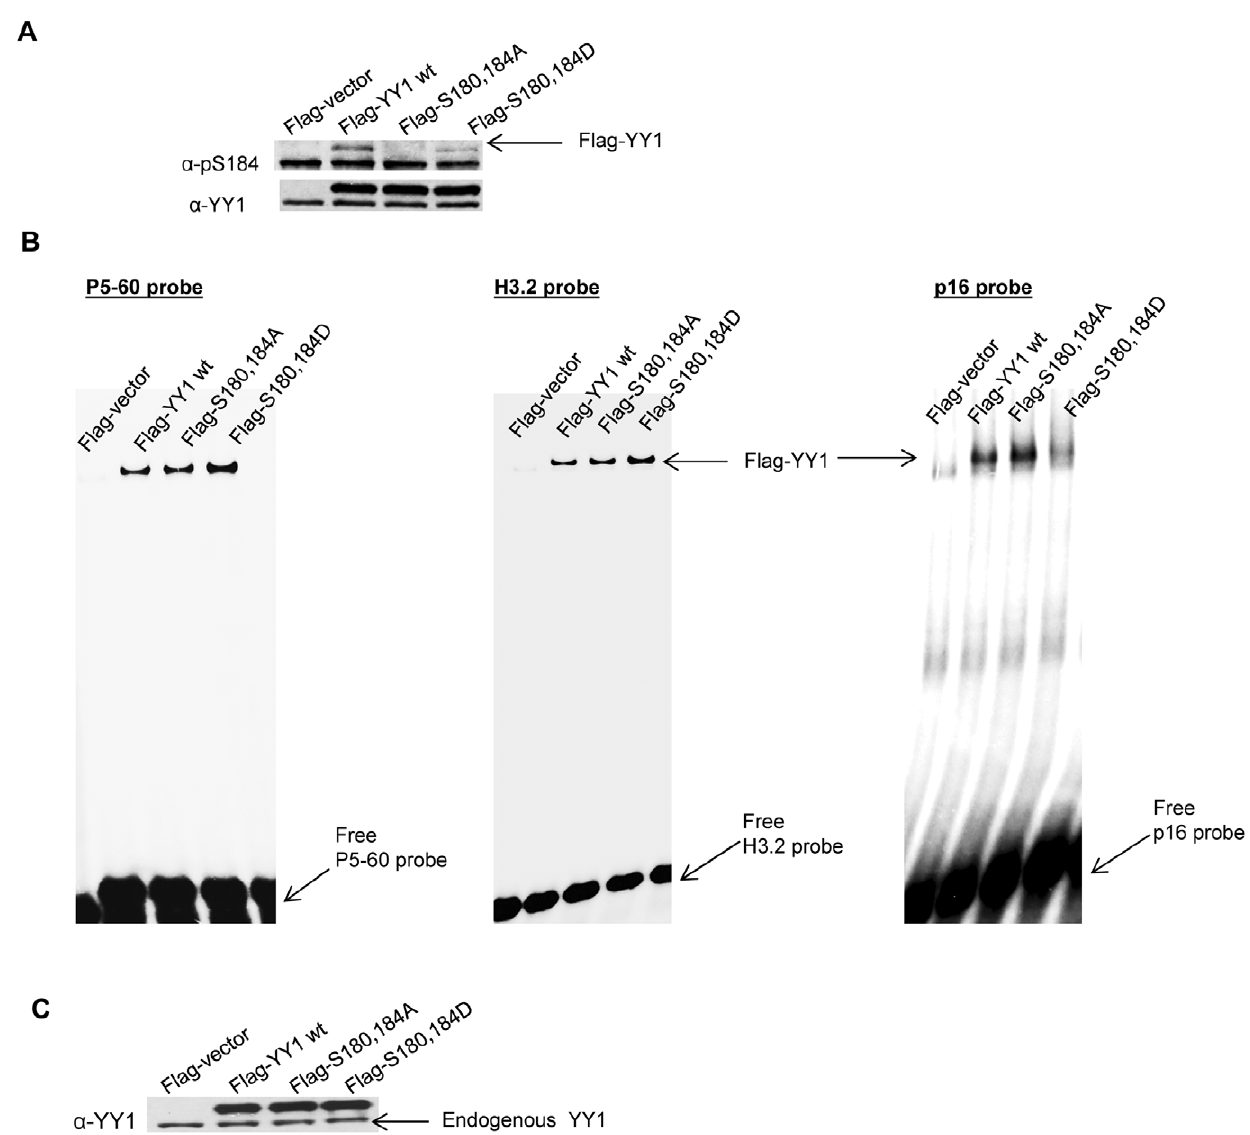
Figure 5. YY1 S180,184D phospho-mutant exhibits an increased DNA binding affinity in vitro. ( A ) Whole cell lysates were prepared from nococdazole treated HEK293 cells transiently transfected with Flag-vector, Flag-YY1 wild type, Flag-YY1 S180,184A and Flag-YY1 S180,184D followed by Western blot. The blot was probed with anti-pS184 antibody, then stripped and reprobed with anti-YY1 antibody. ( B ) Whole cell lysates were prepared from asynchronous HEK293 cells transiently transfected with Flag-vector, Flag-YY1 wild type, Flag-YY1 S180,184A and Flag-YY1 S180,184D. Cell lysates were used in an electrophoretic mobility shift assay (EMSA) using 32 P-labeled H3.2 a , P5-60 and p16 DNA oligonucleotides as probes. ( C ) The same lysates used in the EMSA were also used in a Western blot probed with anti-YY1 antibody to show equal Flag-YY1